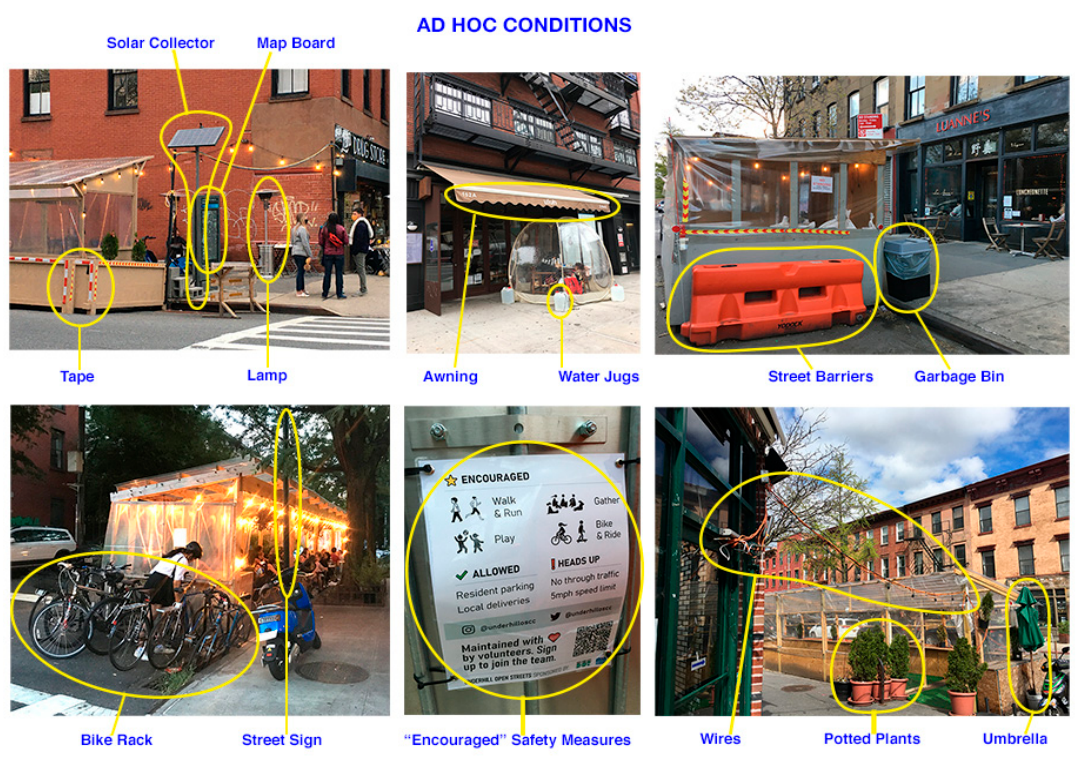
Figure 3. An assortment of ad hoc street paraphernalia representing loose or casual design (Source: